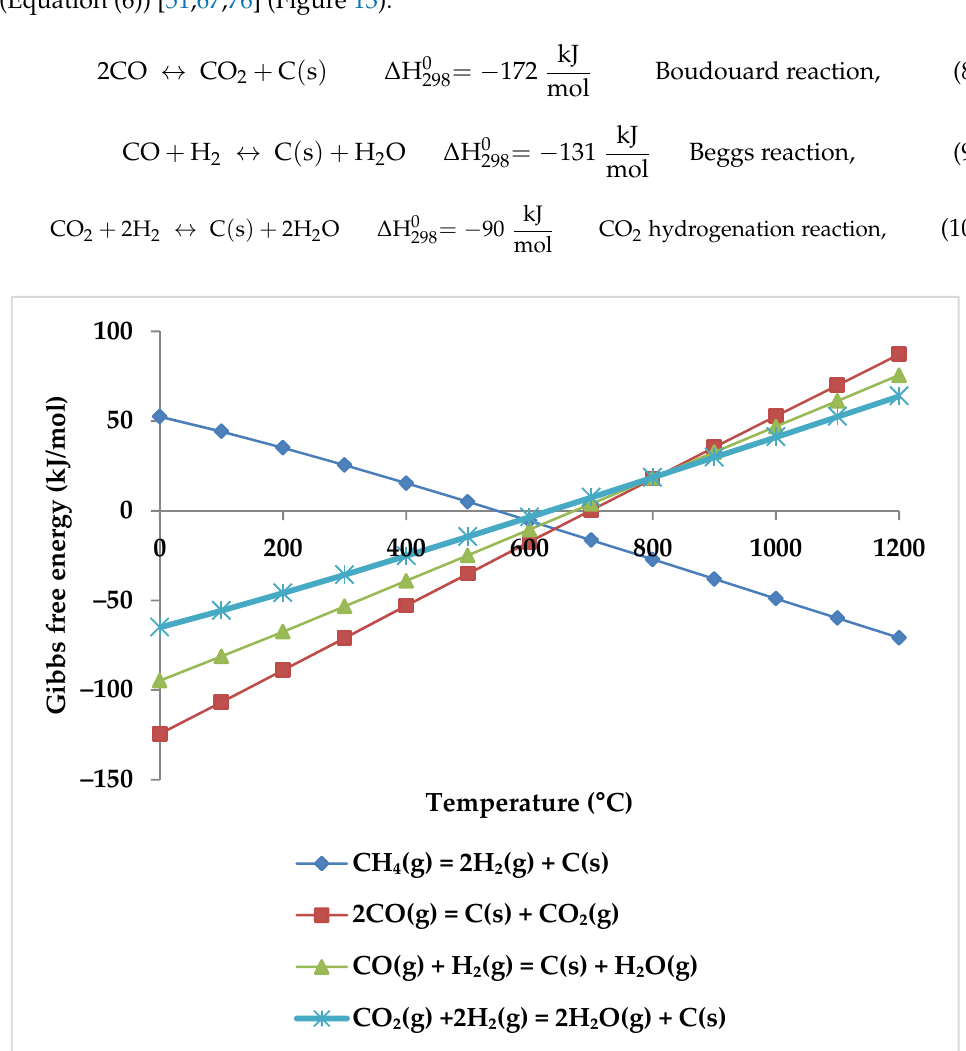
Figure 13. Gibbs free energy diagram for carbon formation reactions.